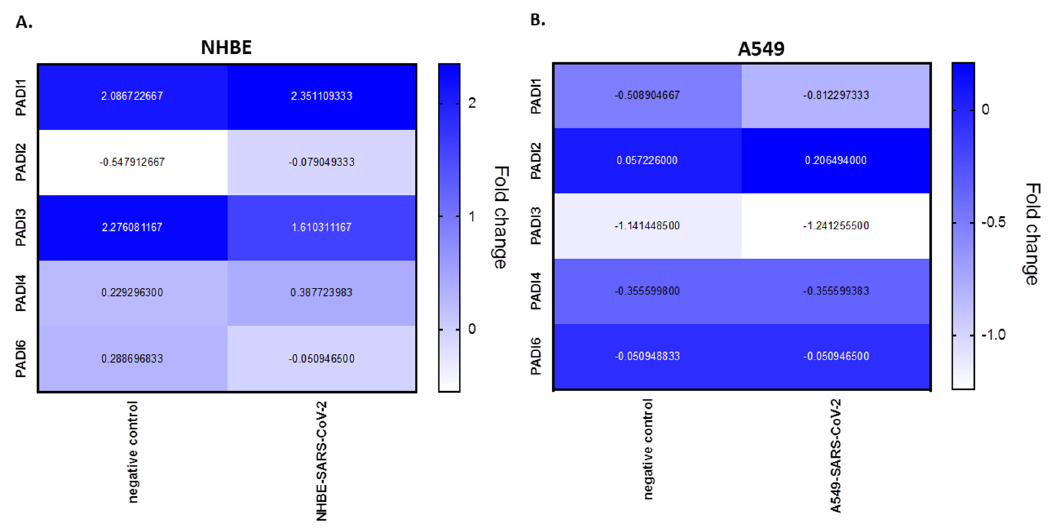
Figure 3. PRJNA615032 BioProject data was analysed for fold change expression for PADI mRNA levels in SARS-CoV-2-infected cell lines, compared with mock. ( A ) NHBE (human bronchial epithelial) cell lines; ( B ) A549 (adenocarcinoma human alveolar basal epithelial) cell lines. Heat map metric is given as blue bar between normalised mRNA levels; negative control represents the mock.